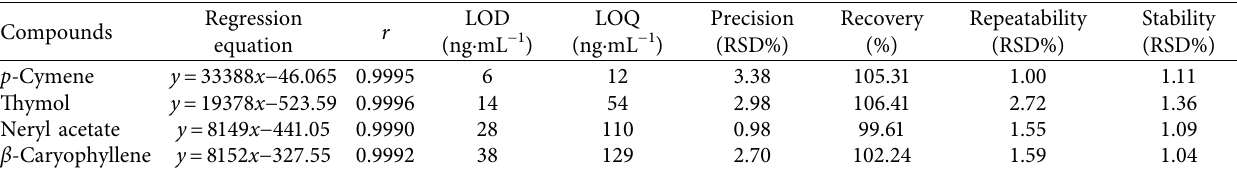
Figure 2: The MRM chromatogram of (a) references and (b) samples (1, p -cymene; 2, thymol; 3, neryl acetate; 4, β -caryophyllene). Table 2: Validation of the optimized GC-MS/MS.